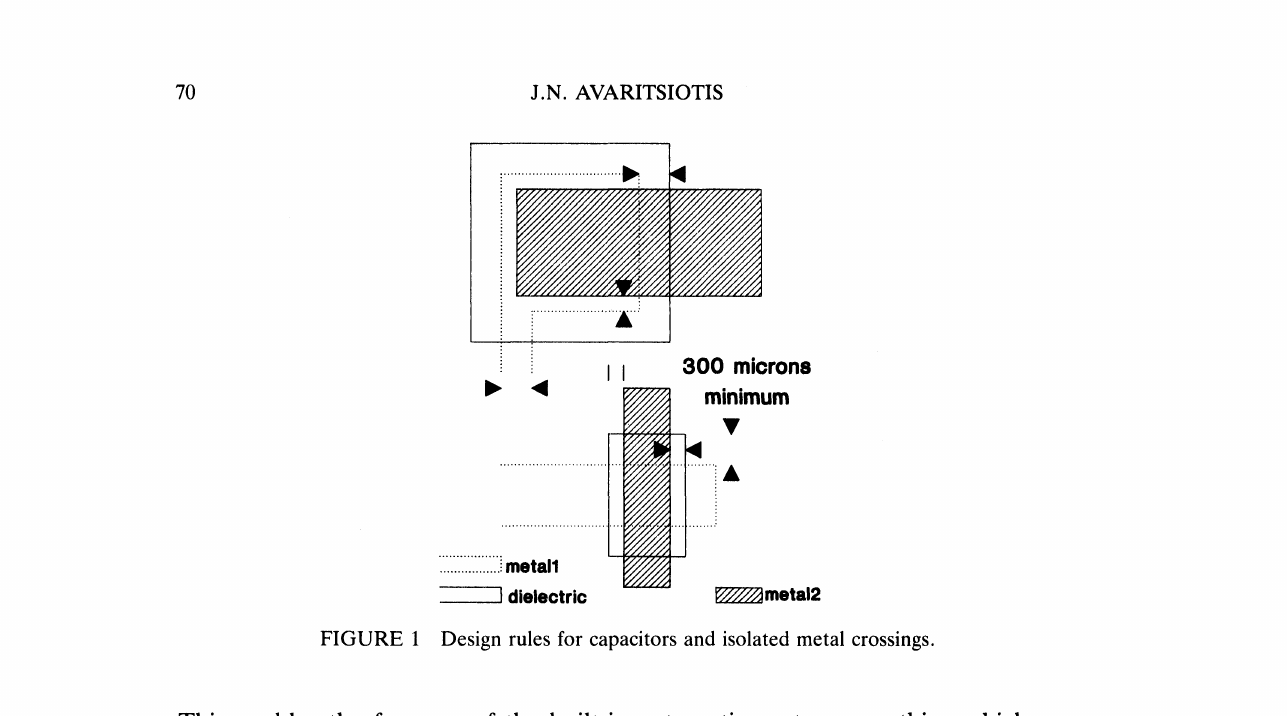
metal1 ] dielectric metal2 FIGURE Design rules for capacitors and isolated metal crossings.